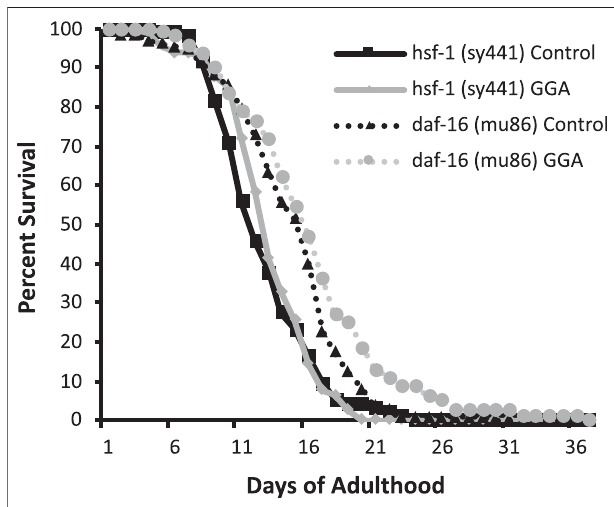
FIGURE 5 | The HSR is required for GGA-mediated lifespan extension. Worms containing mutations in daf-16 (mu86) and hsf-1 (sy441 ) were synchronized and incubated on control NGM plates or plates containing 10 μ M GGA. Worms were scored for viability starting at day 1 of adulthood. Incubation with GGA caused signi fi cant lifespan extension in daf- 16 mutant worms (p-value < 0.05 Mantel-Cox log-rank test) but not worms containingamutationin hsf-1 .Eachcurverepresents ≥ 4pooledtrialsof n ≥ 30 individuals each.